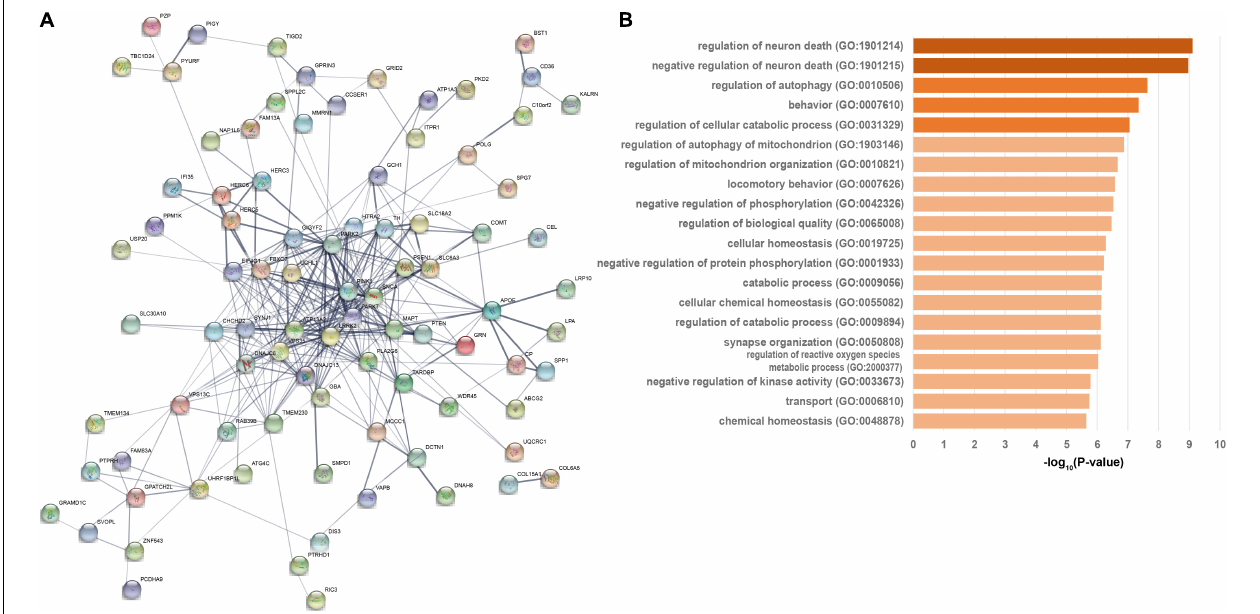
FIGURE 2 | Functional network and biological progresses of Parkinson’s disease-associated genes. (A) Functional network of closely related Parkinson’s disease-associated genes based on the STRING database. Nodes are colored to show the associations, and the thickness of lines connecting nodes indicates the strength of the association between nodes. (B) Biological progresses of gene ontology (GO) terms are involved in functional PPI network this network. The heavier the bar color is, the P-value more significant is.